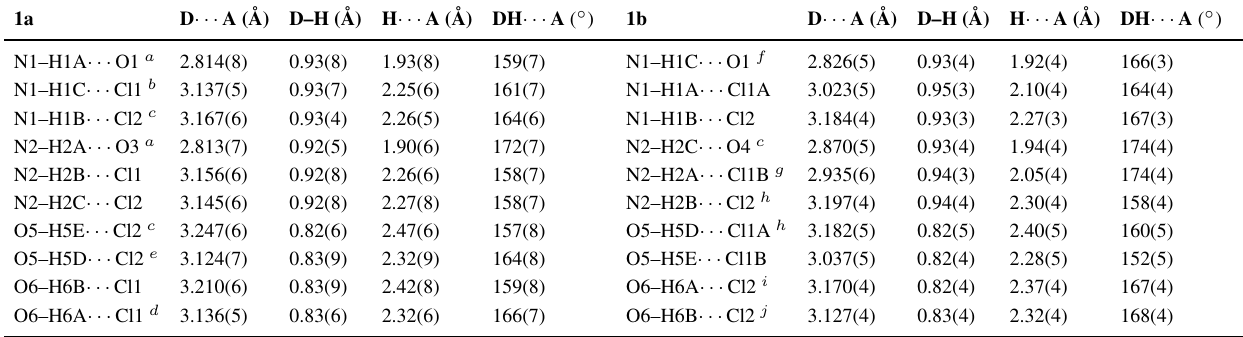
Table 3. Hydrogen bond geometry in 1a and 1b (for the split positions of Cl1 only the shorter hydrogen bond is listed).